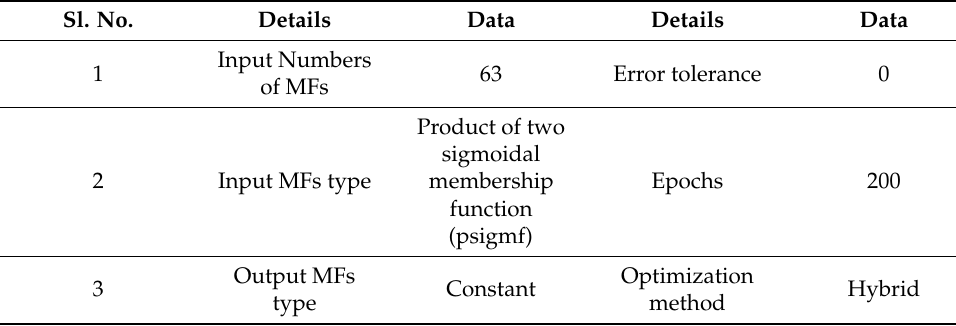
Table 7. ANFIS train data: for frequency control.